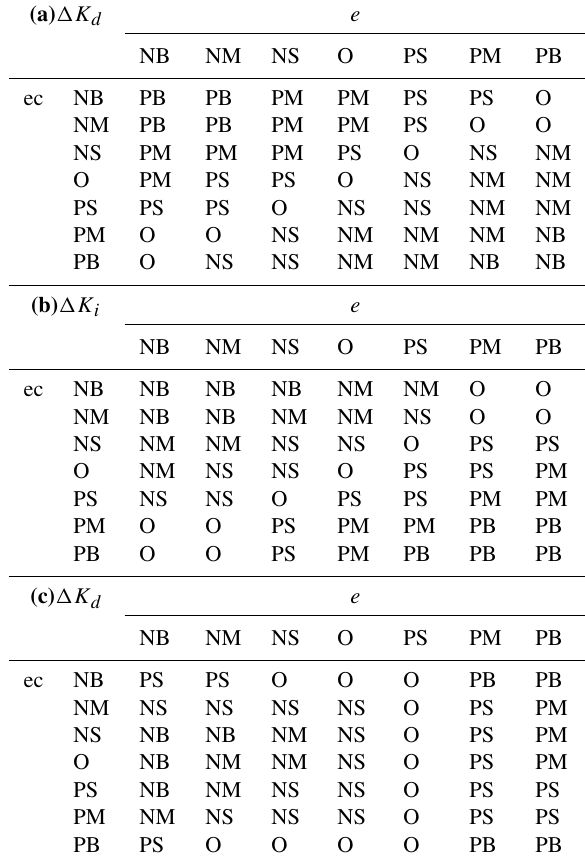
Table 2. Rule table of fuzzy control. (a) Fuzzy rule table of (cid:49)K p . (b) Fuzzy rule table of (cid:49)K i . (c) Fuzzy rule table of (cid:49)K d